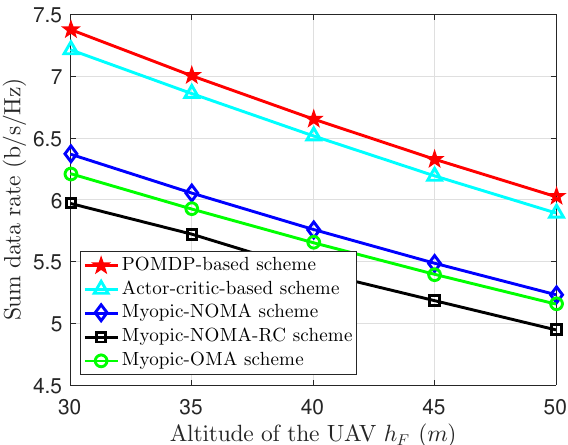
Figure 12. The sum data rate versus various values of the altitude of the UAV.